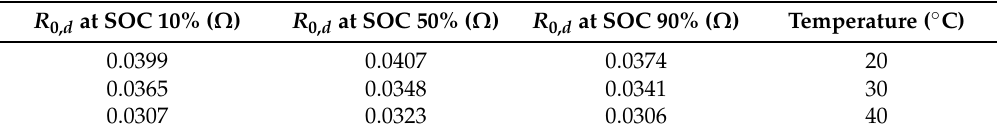
Table 1. Battery discharge resistances measured for different SOC values and temperatures. R 0, d at SOC 10% ( Ω )